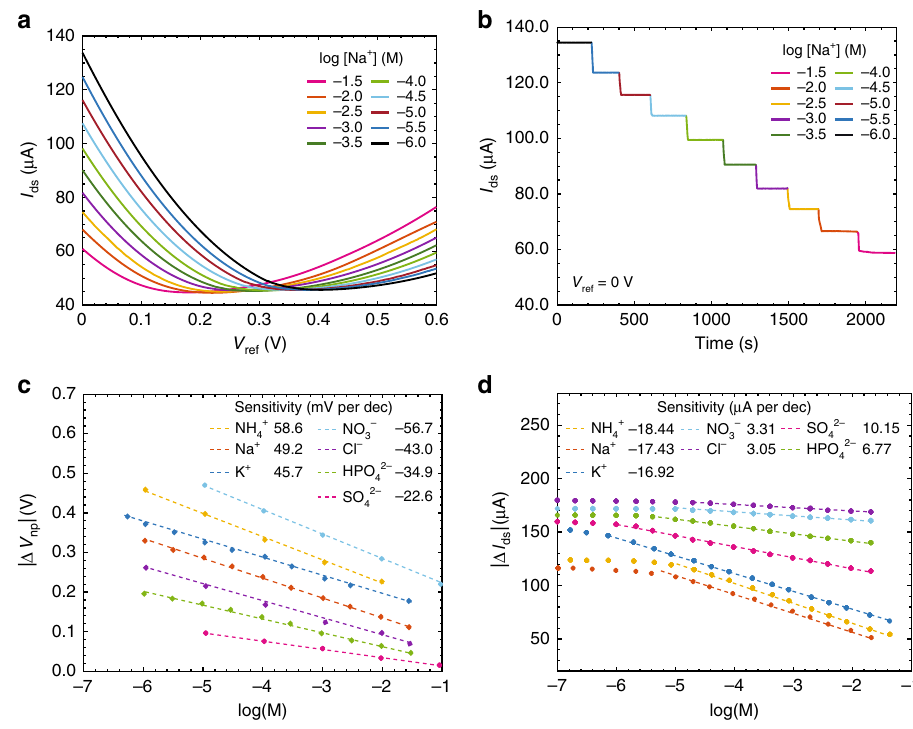
Fig. 3 ISFET sensitivities with respect to their target ions. a The channel current, I ds , of an Na + ISFET versus V ref , for different Na + molar concentrations. b Continuous real-time measurement of I ds for the same Na + ISFET when increasing Na + molar concentrations by half decade steps while keeping V = 0 V. c The changes in V ref np for the different ISFETs with respect to concentrations of their respective target ions, with a linear voltage sensitivities. d The changes in I ds for the different ISFETs with respect to concentrations of their respective target ions, with a linear fi t to extract their current sensitivities.